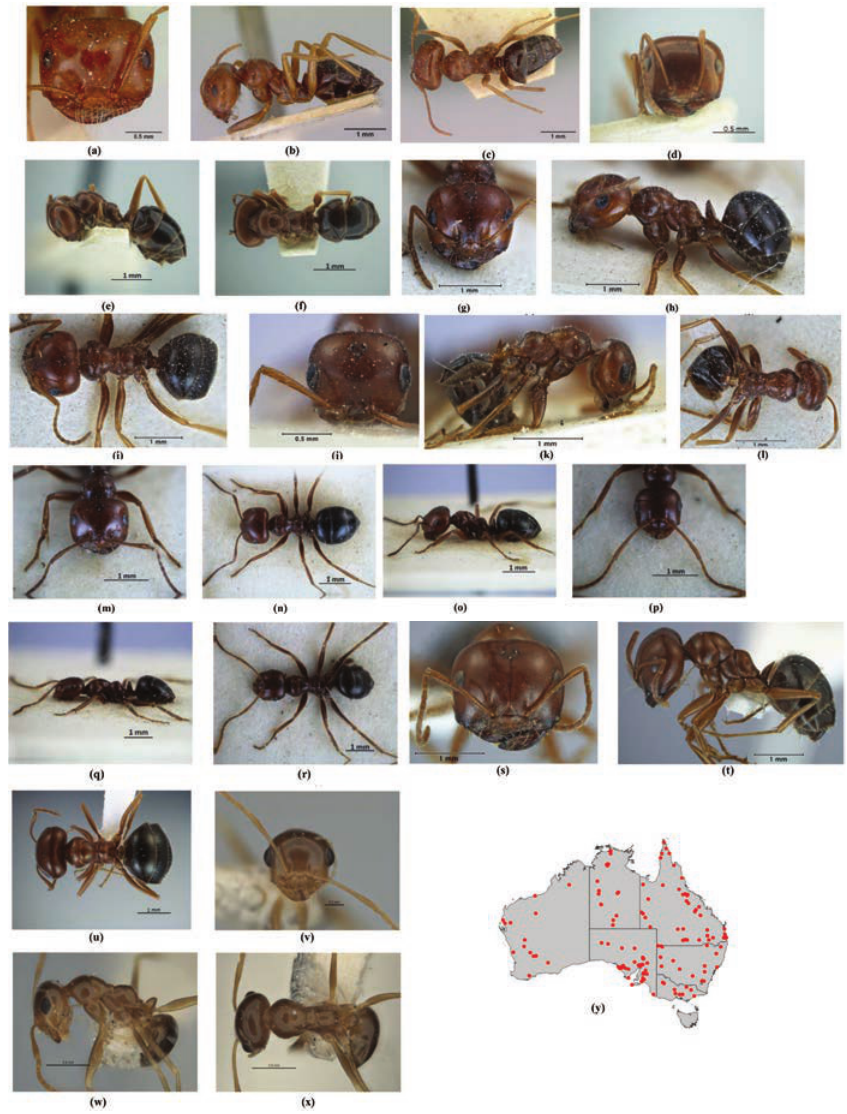
Figure 73. Melophorus turneri Forel: ANIC ‘ turneri aesopus ’ major worker syntype (CAS0172012) frons ( a ), profile ( b ) and dorsum ( c ); MCZ ‘ turneri aesopus ’ major worker syntype (MCZC00023031) frons ( d ), profile ( e ) and dorsum ( f ); BMNH ‘ turneri candida ’ major worker syntype (BMNH Arnold Coll. BM 1934-354) frons ( g ), profile ( h ) and dorsum ( i ); BMNH ‘ turneri candida ’ minor worker syn- type (BMNH: same card and labels as for major worker) frons ( j ), profile ( k ) and dorsum ( l ); MCZ ‘ pil- lipes ’ major worker syntype (MCZ: Cotype 23032) frons ( m ), profile ( n ) and dorsum ( o ); MCZ ‘ pillipes ’ minor worker syntype (MCZ: Cotype 23032) frons ( p ), profile ( q ) and dorsum ( r ); ‘ turneri ’ non–type major worker (ANIC32-059628) frons ( s ), profile ( t ) and dorsum ( u ); ‘ turneri ’ non–type minor worker (ANIC32-900192) frons ( v ), profile ( w ) and dorsum ( x ); distribution map for the species for the spe- cies ( y ). Low resolution scale bars: 0.5 mm ( w, x ); 0.2 mm ( v